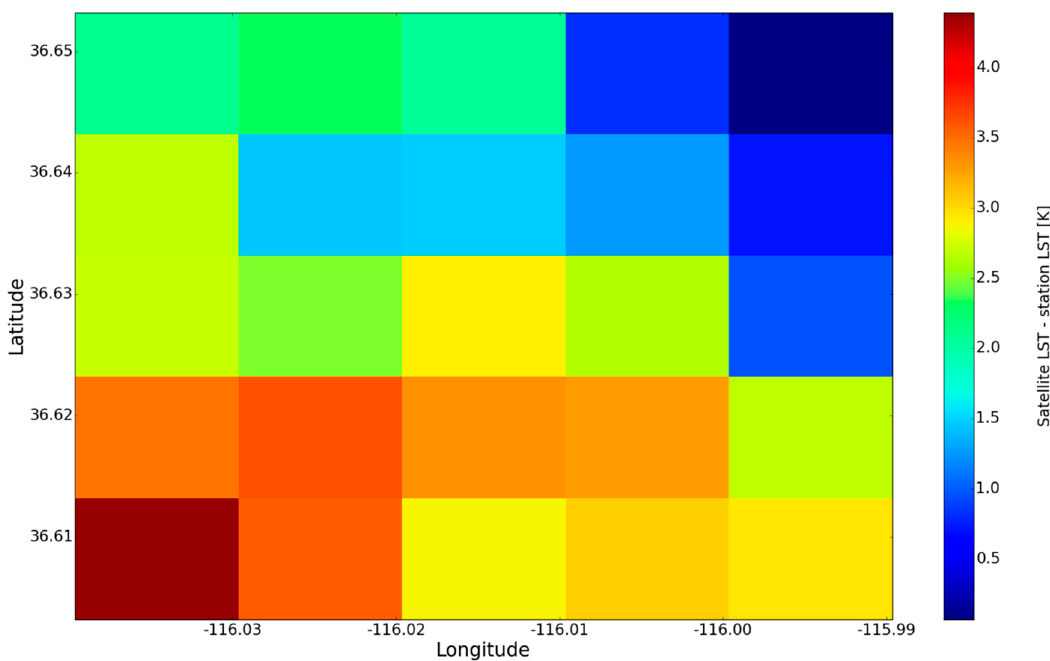
Figure 3. Median accuracies (Advanced Along Track Scanning Radiometer (AATSR) Land Surface Temperature (LST)–in situ LST) during daytime for June 2010 for the individual pixels in a 5 × 5 pixel area around DRA station, which is located on the pixel in the centre. Each pixel covers an area of 0.01° × 0.01°.